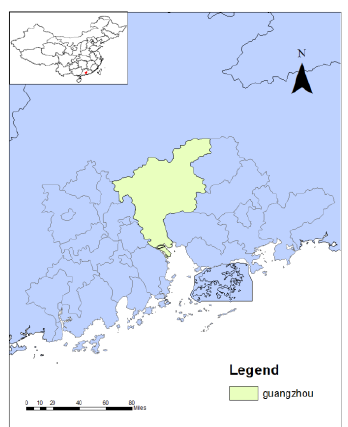
Figure 1. The study area-Guangzhou, China